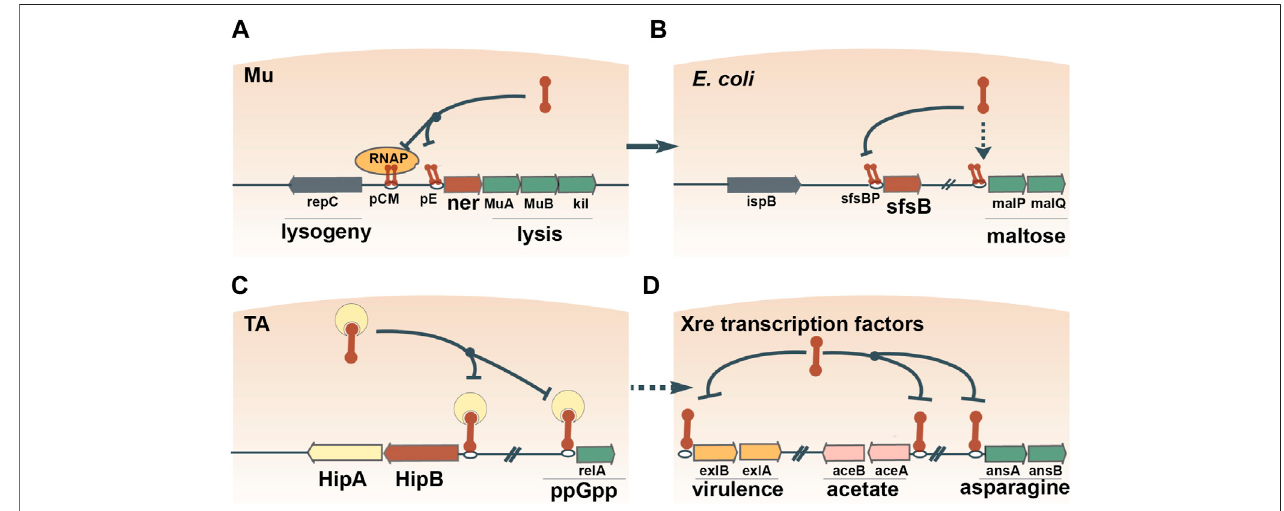
FIGURE 3 | Recruitment of transcription factors from MGEs to regulate host gene expression. One example is Ner, which contains an Xre-family HTH domain and regulatesthelysis-lysogenyswitchofbacteriophage Mu (A) .TheaminoacidsequenceofNeris68%identicaltothemaltoseoperon-activatingtranscriptionfactorSfsB, indicating the recent recruitment of a Ner homolog for the regulation of host carbon metabolism (B) . Xre domains are widespread in antitoxin proteins, such as HipB, which autoregulate their own expression and the expression of other host genes (C) . Antitoxins often disassociate from their TA operons and assume dedicated roles as transcription factors (D)